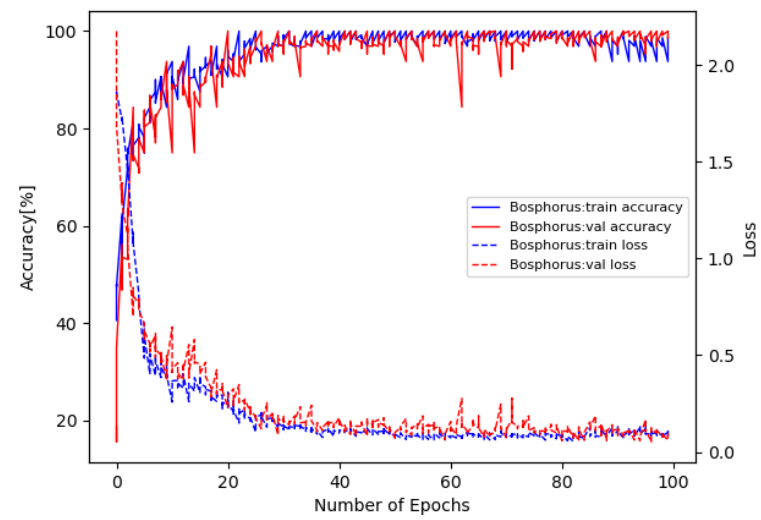
Figure 5. Loss and accuracy on Bosphorus